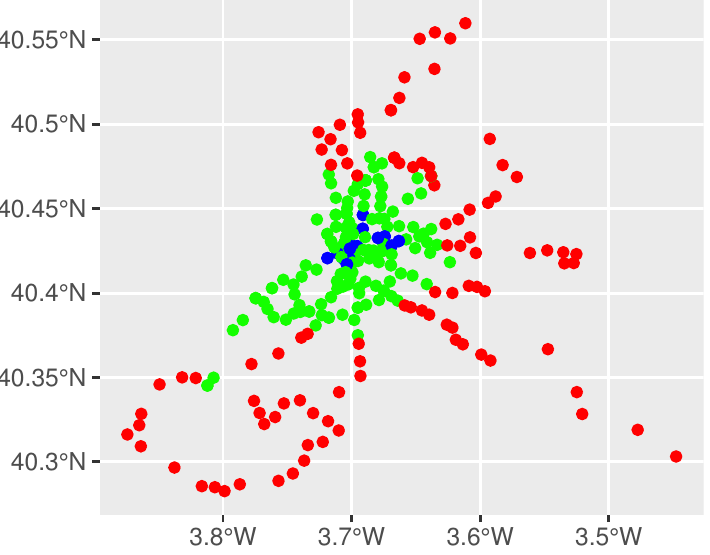
Figure 9. Spatial distribution of clusters. In red the Cluster 2 stations, in green the Cluster 1 stations and in blue the Cluster 3